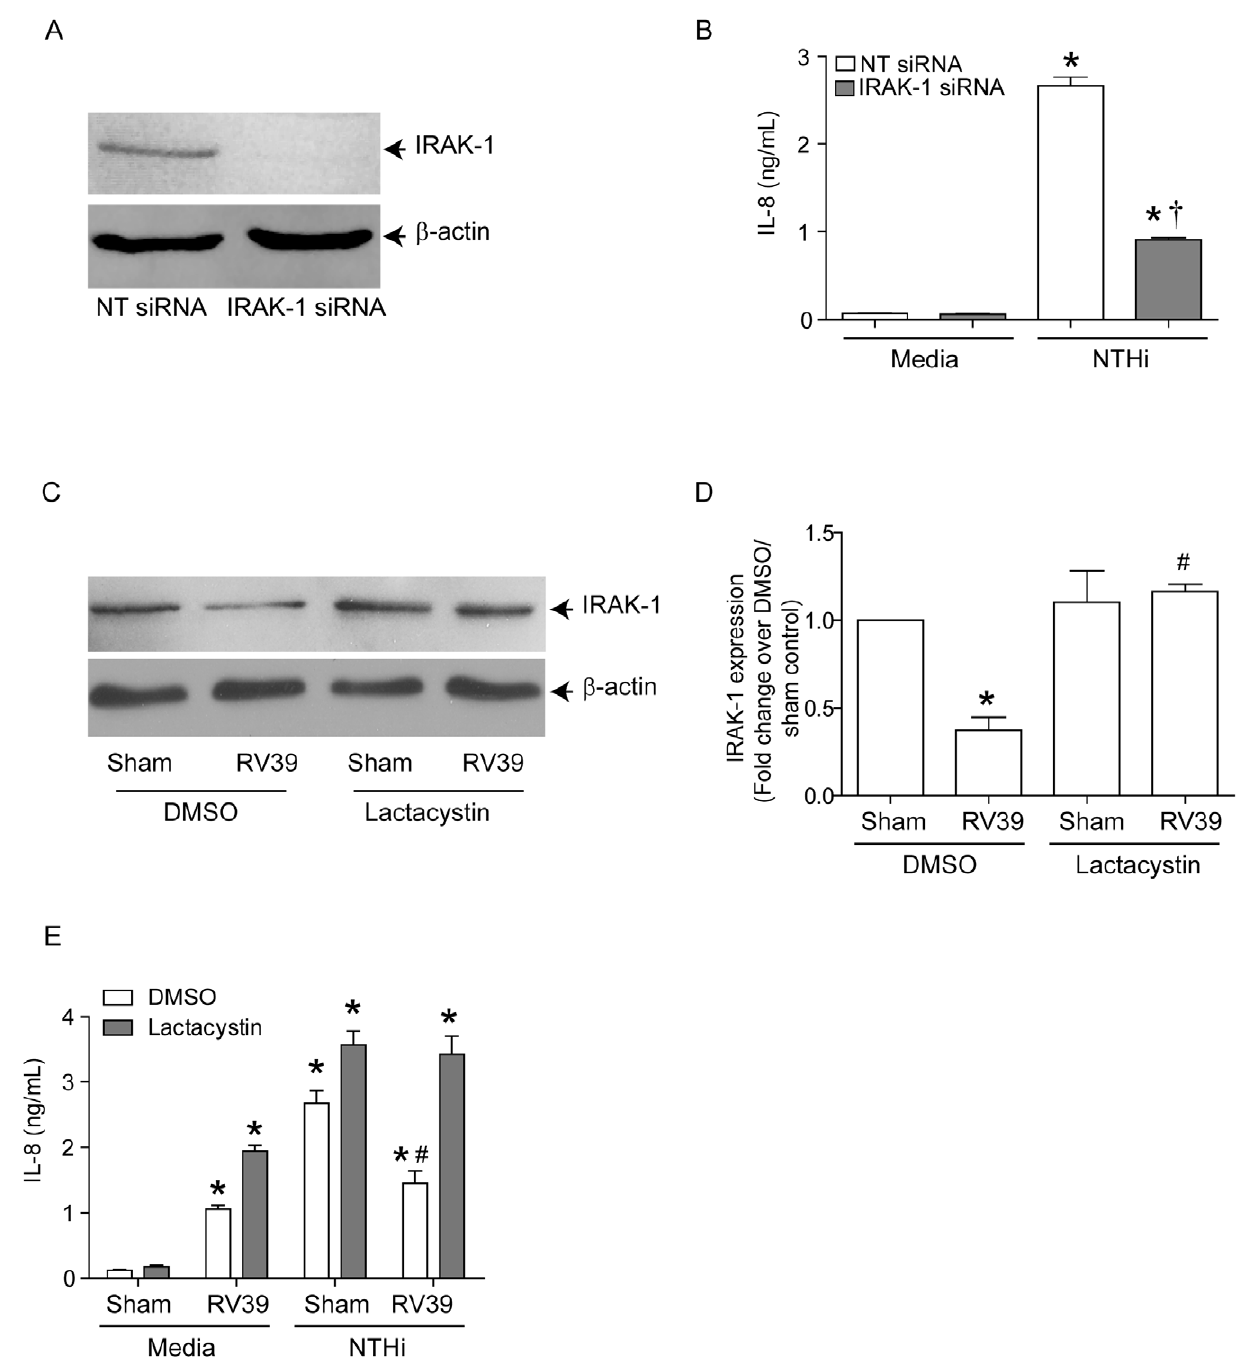
Figure 7. IRAK-1 is required for NTHi-stimulated IL-8 production. BEAS-2B cells were transfected with non-targeting (NT)- or IRAK-1 siRNA and grown for 3 days. (A) Cell lysates were prepared from transfected cells and subjected to Western blot analysis to confirm knockdown of IRAK-1. (B) Transfected cells were infected with NTHi, incubated for 3 h and IL-8 in the media determined. BEAS-2B cells were infected with sham or RV39 in the presence or absence of 5 m M lactacystin and incubated for 24 h. (C and D) Cells were either harvested for determination of IRAK-1 expression by Western blot analysis and band intensities of IRAK-1 were normalized to b -actin. (E) Cells were then infected with NTHi and IL-8 in the media was examined. Western blot images are representative of 3 experiments. Data in B, D and E represents mean 6 SEM calculated from 3 independent experiments performed in triplicate (* p # 0.05, ANOVA, different from sham; { , p # 0.05, ANOVA different from NT-siRNA transfected cells; # p # 0.05, ANOVA, different from DMSO treated RV/NTHi-infected